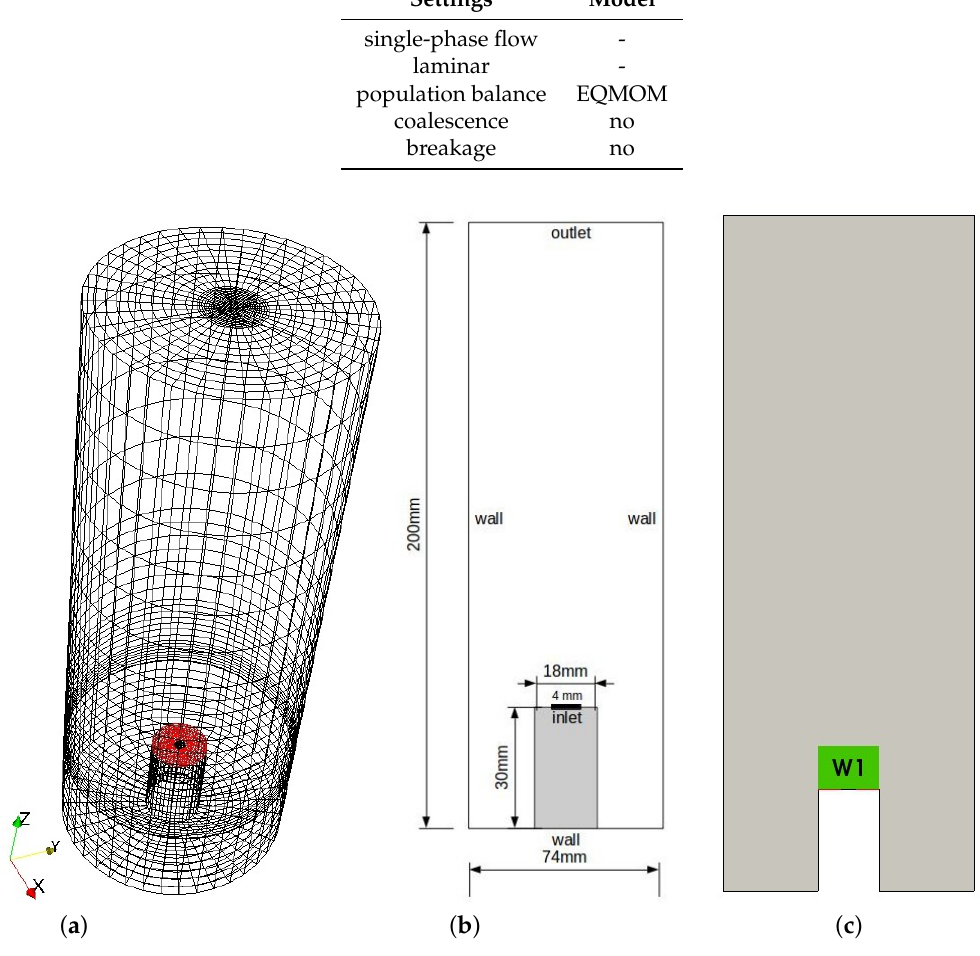
Figure 8. ( a ) Schematic of hexahedral mesh [67]. ( b ) The specifications of the reactor and ( c ) the location of volume